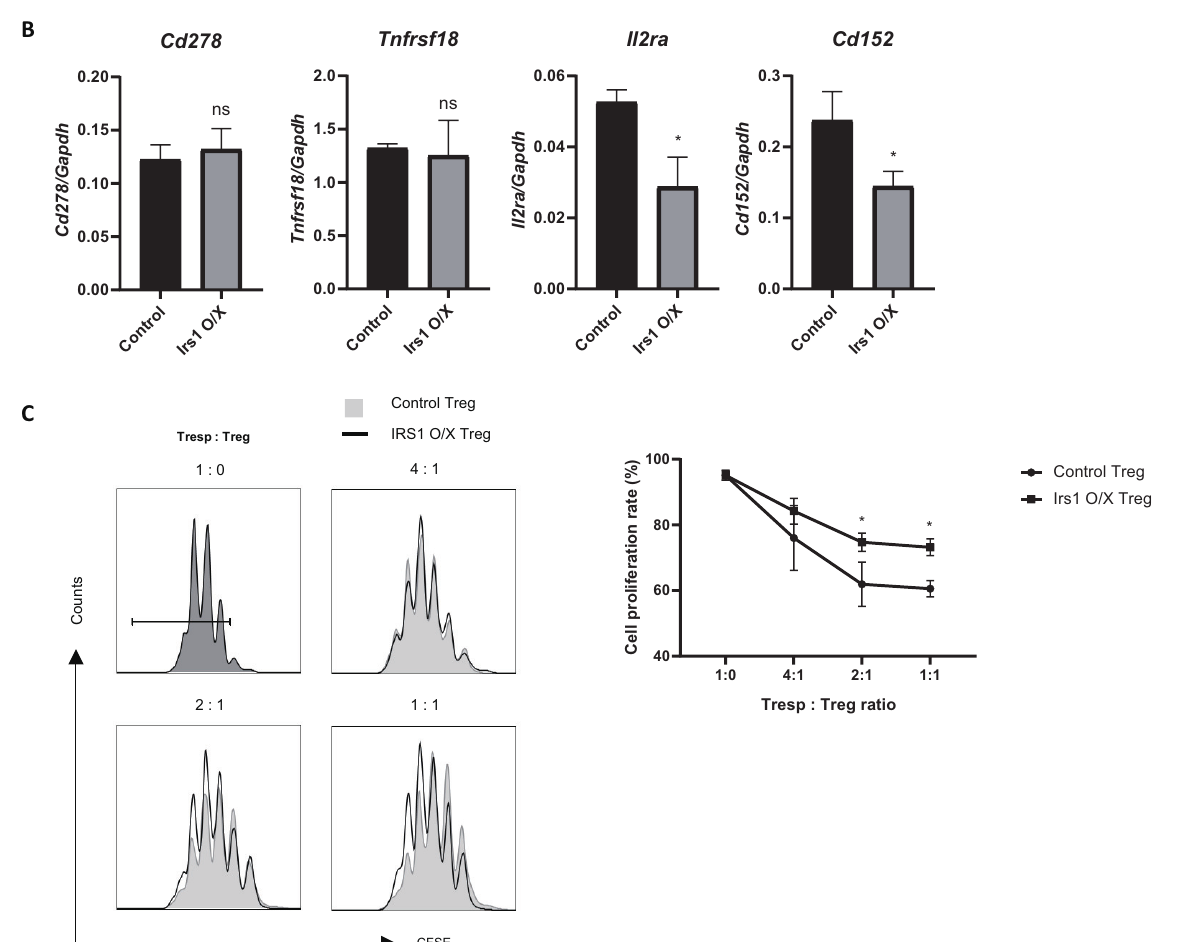
Figure 4. IRS1 downregulates CD25 and CTLA4 on Treg cells and suppresses their immunosuppres- sive functions. IRS1 overexpression was performed as in Figure 2. ( A ) GFP+ Treg cells (transduced by MIEG3-IRS1) were gated, and expression of ICOS, GITR, CD25, and CTLA was measured via flow cytometry. ( B ) RNA was isolated from GFP+ cells. Expression of mRNA encoding ICOS, GITR, CD25, and CTLA4 was measured via qRT-PCR. ( C ) Thy1.1 + CFSE-labeled responder CD4 T cells were mixed with IRS1-overexpressing Treg cells in various ratios and then cultured for 3 days with anti-CD3/CD28 beads. After 3 days, responder CD4 T cells were stained with a Thy1.1 antibody and then analyzed via flow cytometry. All data are representative of three independent experiments. The bar graph next to the flow cytometry plot shows data pooled from three independent experiments. The error bars represent the SD, and ( A , B ) p -values were calculated using a t -test. ( C ) p -values were calculated using two-way ANOVA/Tukey test * p < 0.05. ns: not